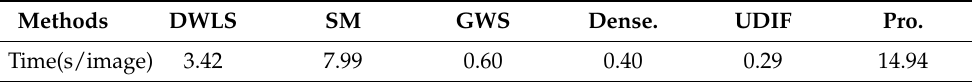
Table 3. Computation time of the six compared methods (image size: 512 × 512).